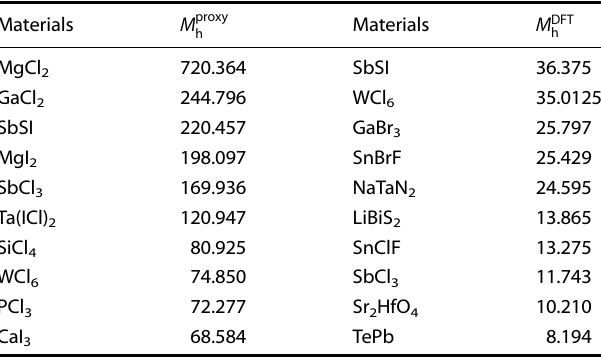
Table 2. Comparison of M h from Newnham ’ s proxy and DFT computation.